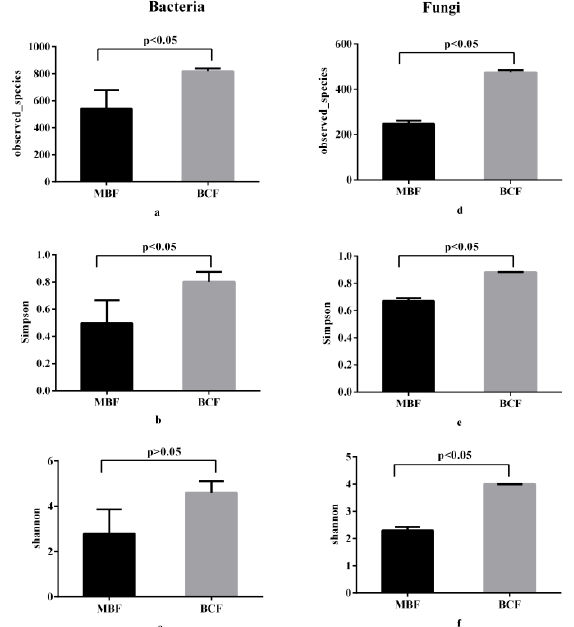
Figure 3. Alpha diversity indices of bacterial and fungal taxa for the BCF and MBF samples from moso bamboo.